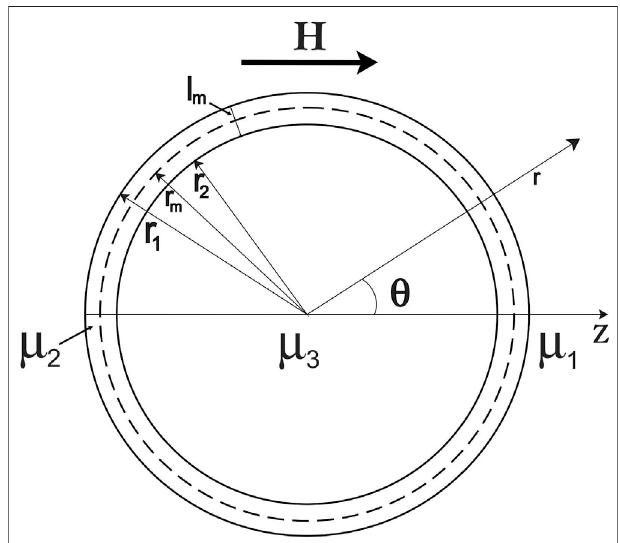
FIGURE 6 | Model of a magnetoliposome in a DC magnetic fi eld. MLs areimmersedinasolutionwithpermeability μ 1 .ThedirectionoftheDCis z ,the interior of the MLs is fi lled with a material of magnetic permeability μ 3 ( μ 1 (cid:1) μ 3 ), and the lipid membrane has magnetic permeability μ 2 . The width of the lipid membrane is l m , the radius of the outer and the inner membranes are r 1 and r 2 , respectively, and the membrane radii are denoted by r m